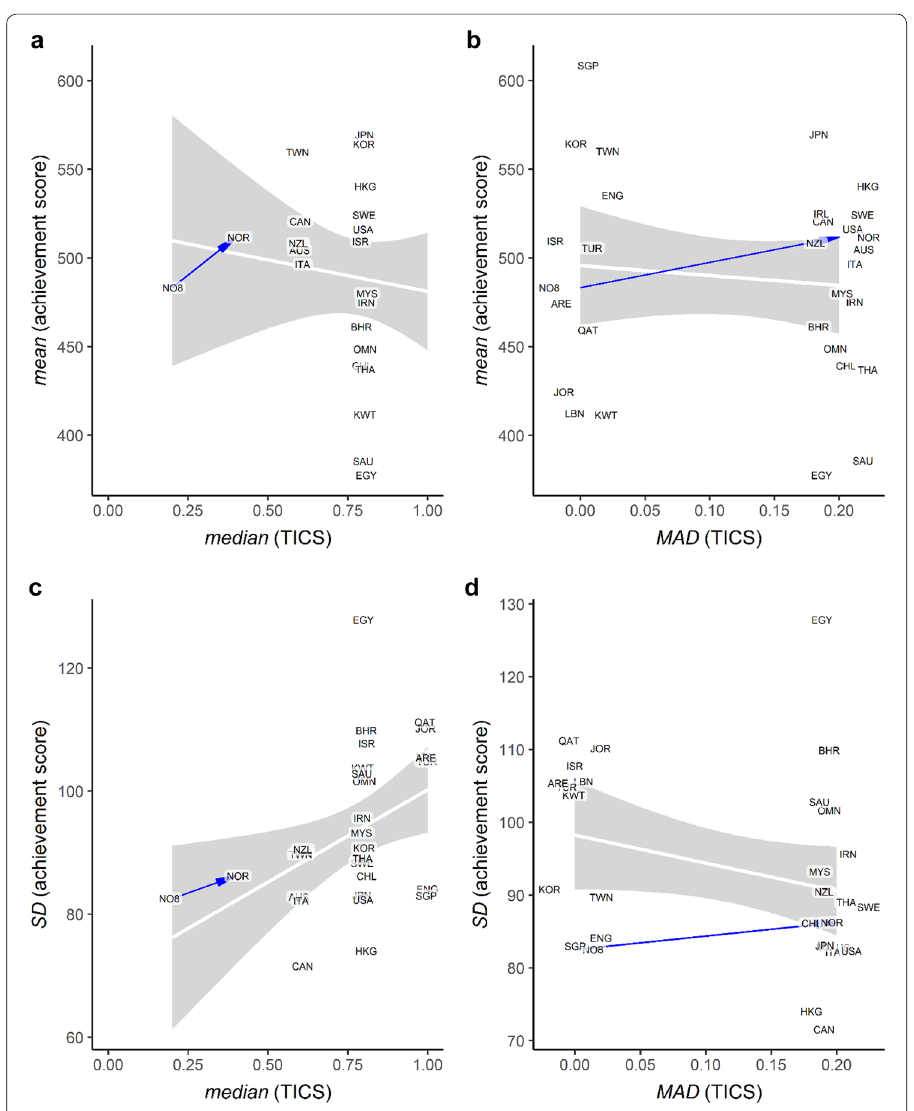
Fig. 9 a – d Scatterplots of between-country relationships in physics between central tendency (mean achievement and median TICS) and spread (standard deviation of achievement and median absolute deviation of TICS). The white line is the best simple linear fit line, and the gray band is its 95% confidence interval (bootstrapped from 10,000 draws). As there was little between-country variation in median absolute deviation (MAD) of TICS, the x -axis values in b and d were slightly jittered to increase visibility of points. The blue arrow indicates the shift from Norway grade 8 to grade